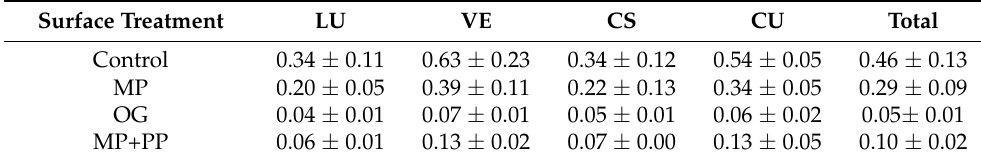
Table 3. Mean roughness (Ra, in µ m) of the surface-treated CAD/CAM ceramics. Surface Treatment LU VE CS CU Total Control 0.34 ±